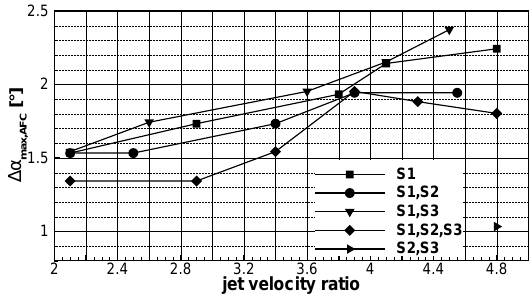
Figure 17. Stall angle offset for different velocity ratios and segment combinations.